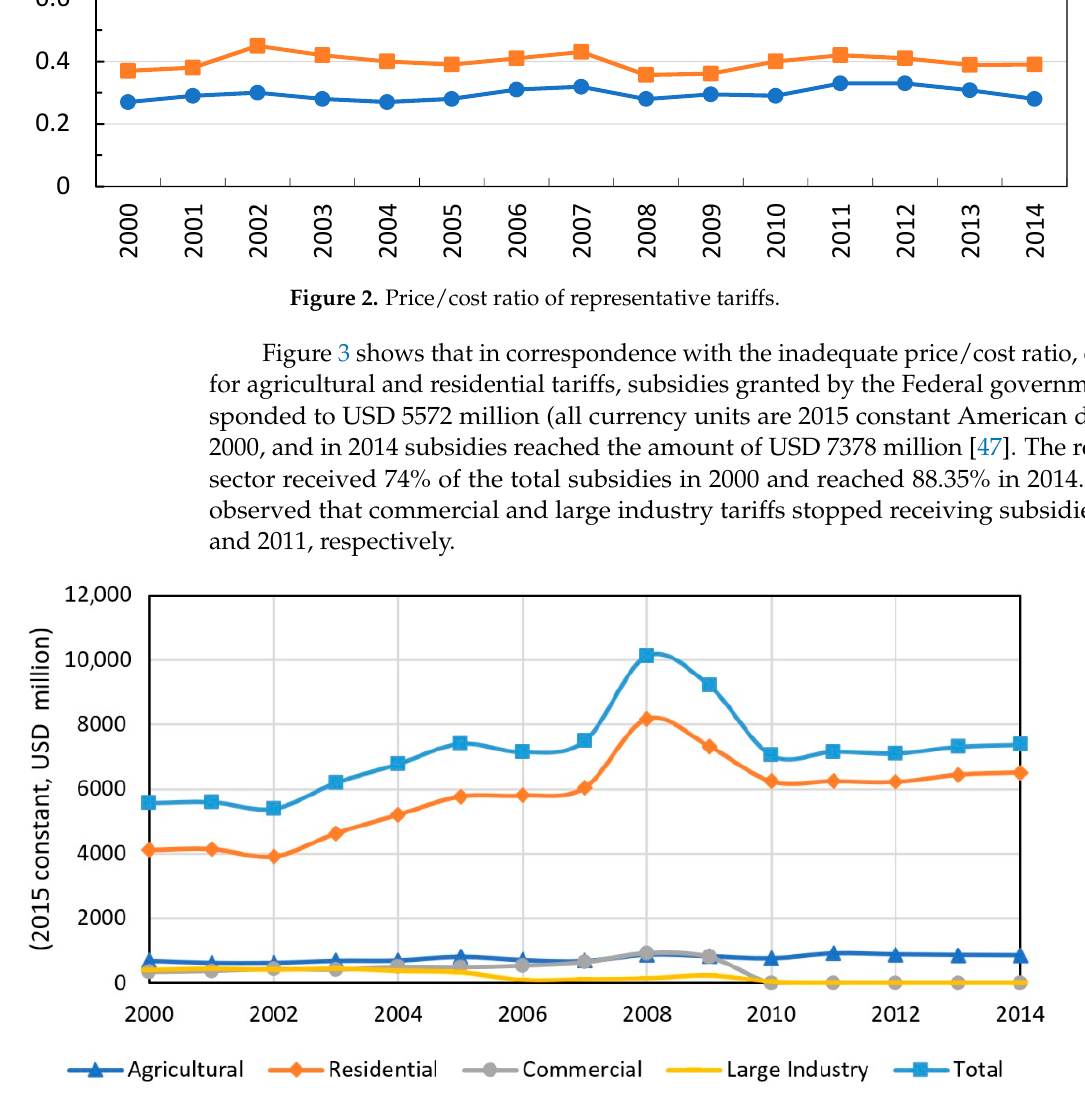
Figure 3. Subsidies granted by tariff (2015 constant, USD